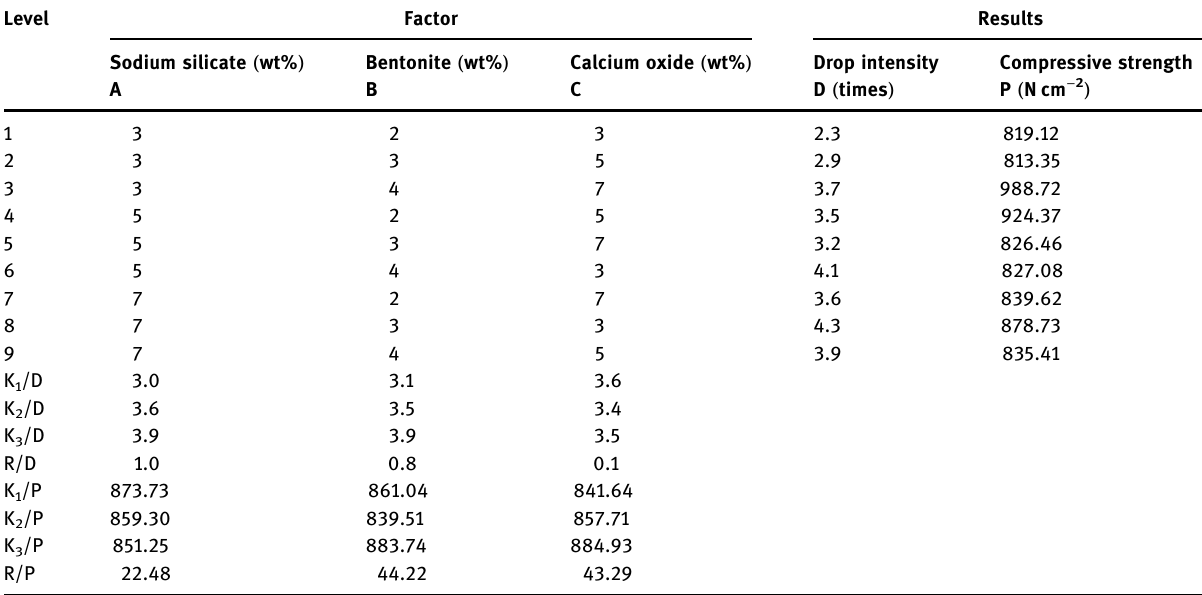
Table 10: Orthogonal test design and results